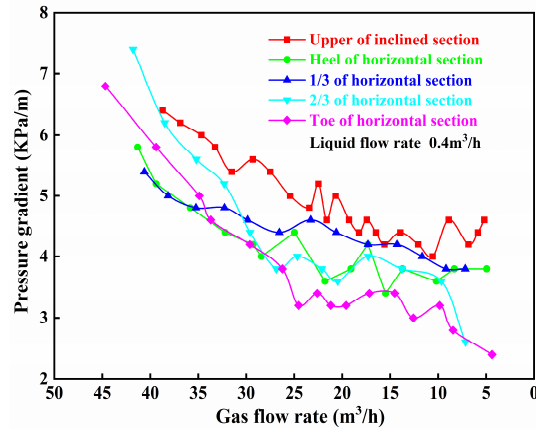
Figure 5. Pressure loss of the deviated section at different depths of tubing.